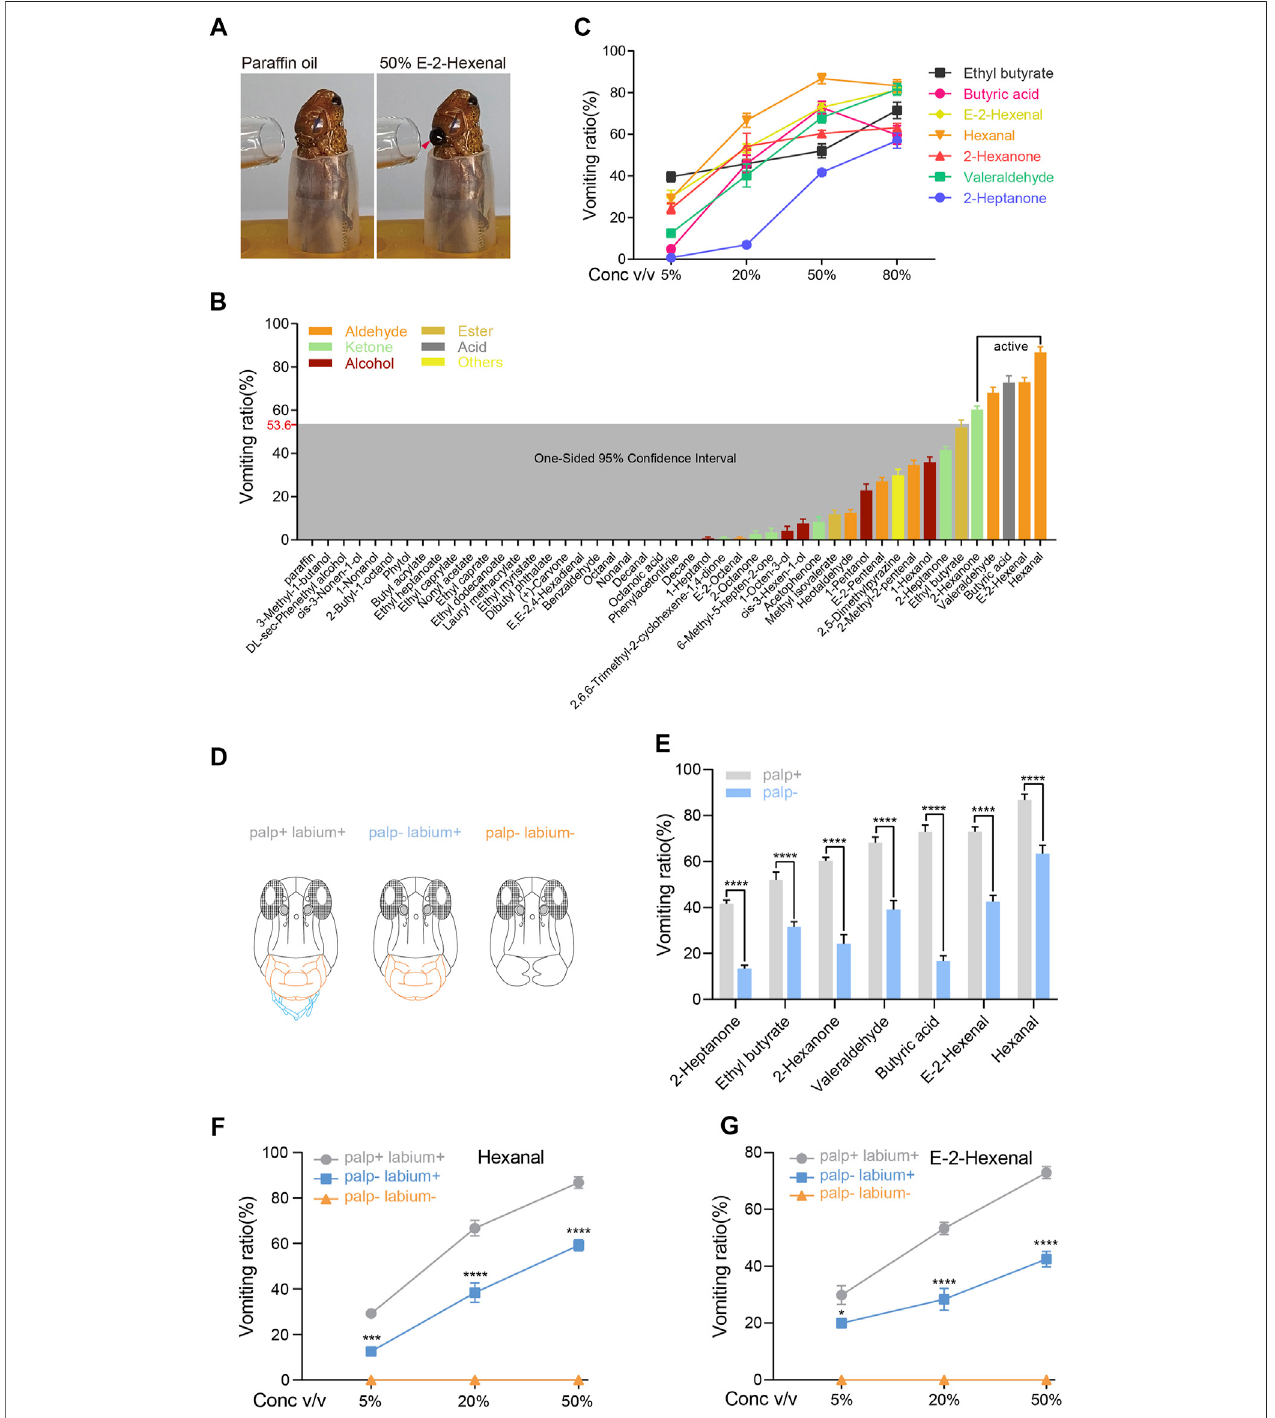
FIGURE 1 | Palps are crucial sensory organs in locust olfactory vomiting. (A) The example of locust vomiting to 50% v/v E-2-hexenal and paraf fi n oil (solvent). The arrow indicates the vomit. (B) Vomitingratio (the number ofvomiting individuals divided by thetotal number of insects tested) of locusts to different kinds ofodorants. All compoundsweretestedat50%v/vdilutionsinparaf fi noil. n =6(24locustsperreplicate)foreachcompound.Theshadedboxmarkstheone-sided95%CIofthemean vomiting ratio from all tested compounds. (C) The dose-dependent curve of locust vomiting in response to seven chemicals. n = 3 – 6 (24 locusts per replicate) for each independenttest. (D) Frontal view ofa locust head showing different treatments ofthe palp and labium. (E) Vomiting response assaysof palp-retained locusts and palp-ablated locusts to seven chemicals. All chemicals were tested at 50% v/v dilution. n = 6 (24 locusts per replicate) for each assay. Statistical test: two-way ANOVA with uncorrected Fisher ’ s LSD test. (F,G) Vomiting response assays of locusts in different treatment groups in response to hexanal (F) and E-2-hexenal (G) at concentrations of 5 – 50% v/v. n = 6 (24 locusts per replicate) for each assay. Statistical test: two-way ANOVA with uncorrected Fisher ’ s LSD test. For all analyses, statistical differences are represented as follows: * p < 0.05, *** p < 0.001, and **** p < 0.0001. Data are represented as the mean ± SEM.